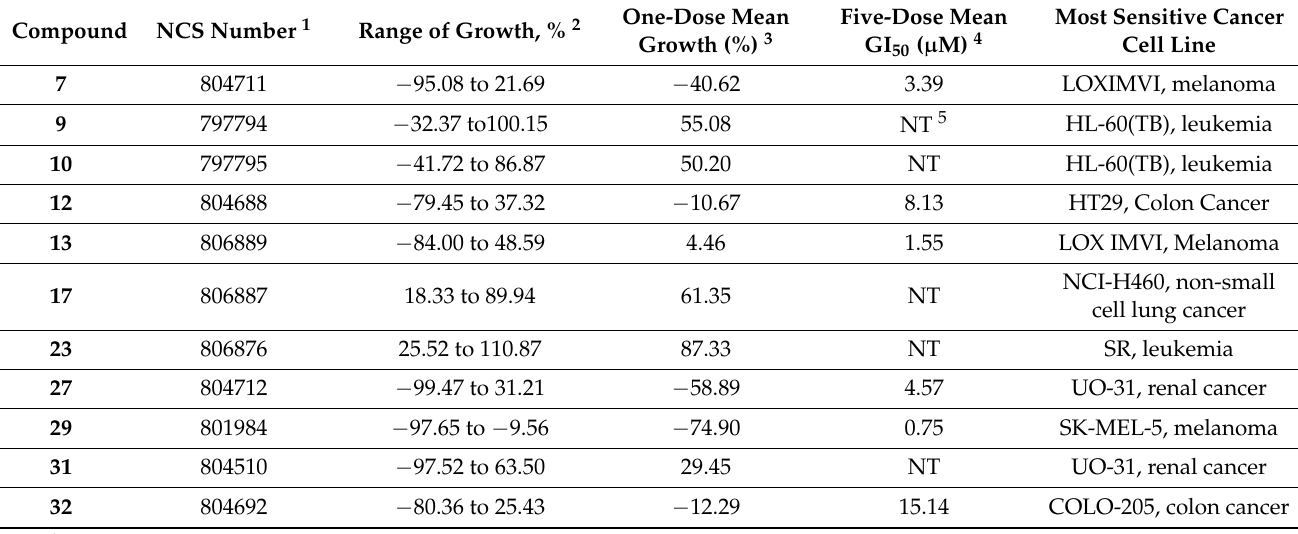
Table 1. Anti-proliferative activity of compounds 7 , 9 , 10 , 12 , 13 , 17 , 23 , 27 , 29 , 31 , and 32 .